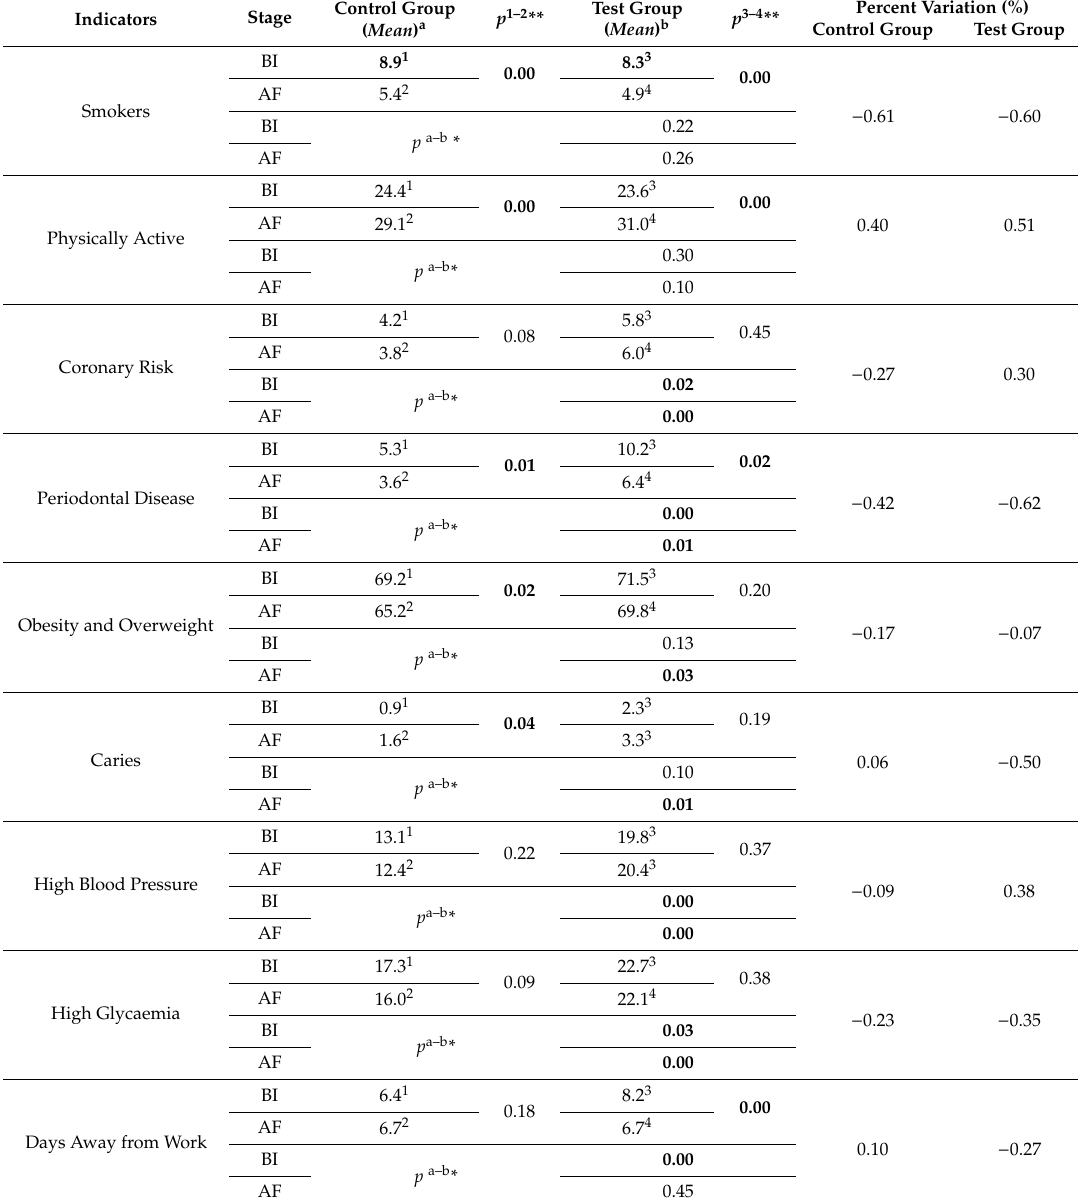
Table 3. Mean comparison within and among control and test